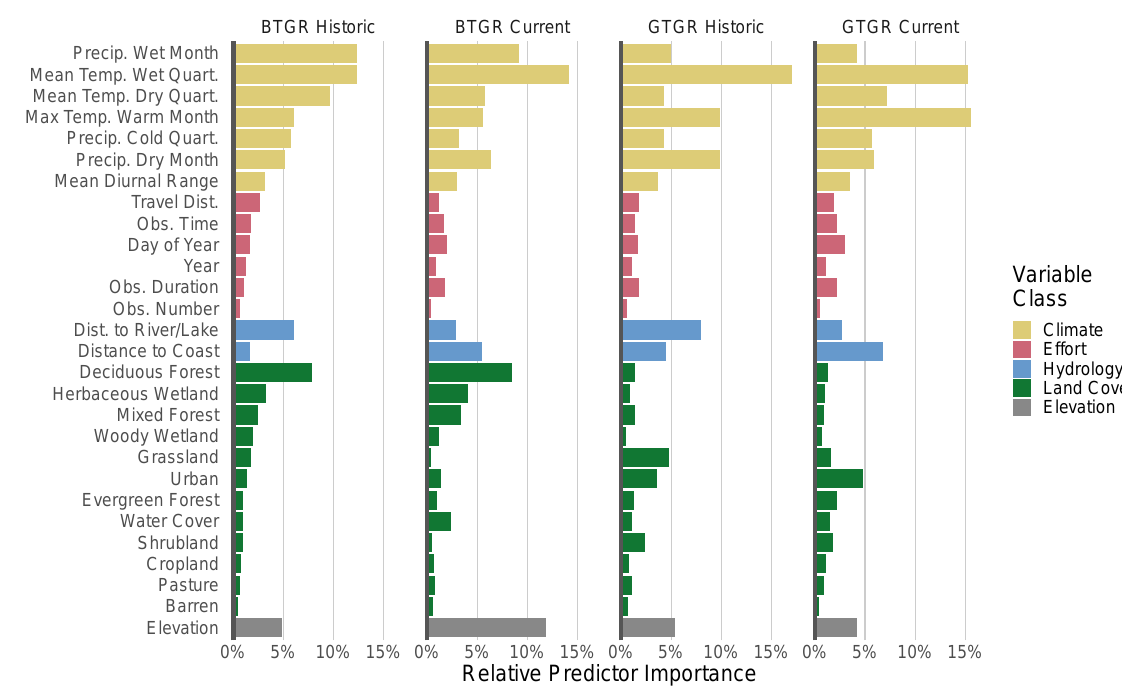
Figure 4 – Importance of environmental predictors for the boat-tailed grackle (BTGR) and the great- tailed grackle (GTGR) historic and current species distribution models (SDMs). Relative predictor importance measures how informative the predictors were for classifying presence or absence points within each model (% total GINI index). The predictor colors indicate whether a predictor was a measure of climate (yellow), observer effort (red), distance to water (blue), land cover classi- fication (green), or elevation